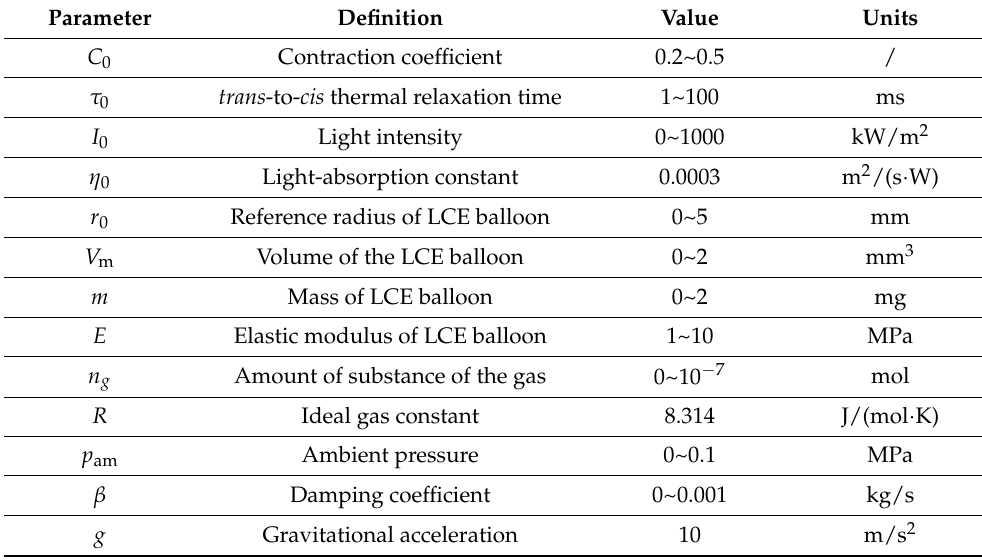
Table 1. Material properties and geometric parameters.